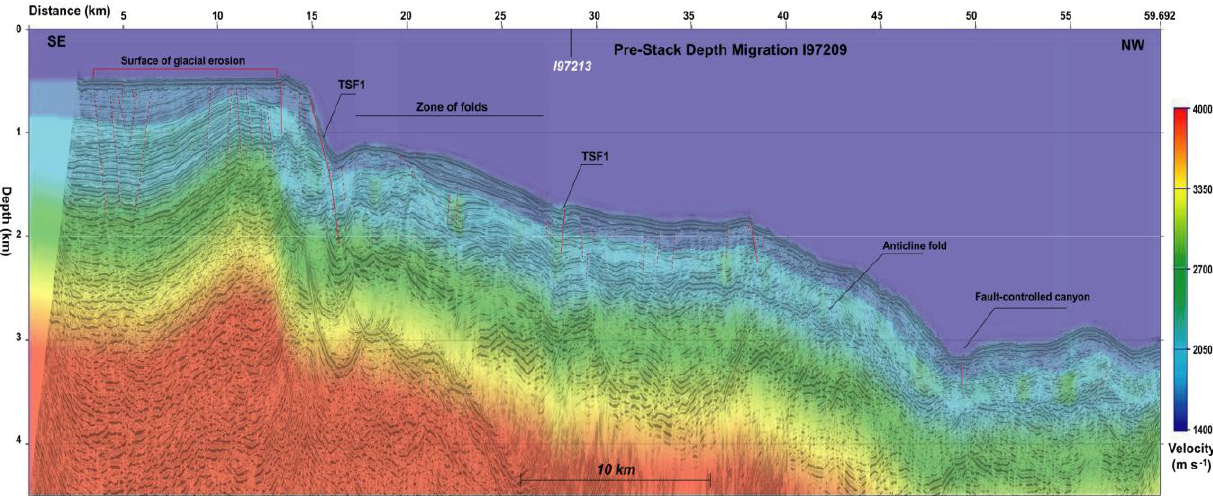
Figure 3. PreSDM section of line I97209, on which the velocity model is superimposed. Thick red lines: main faults. Dashed red lines: minor fault and fractures. The BSR and the main geological features are reported. TFS1: Transcurrent Fault System 1; Vertical exaggeration 1:4; Crossing lines are indicated.